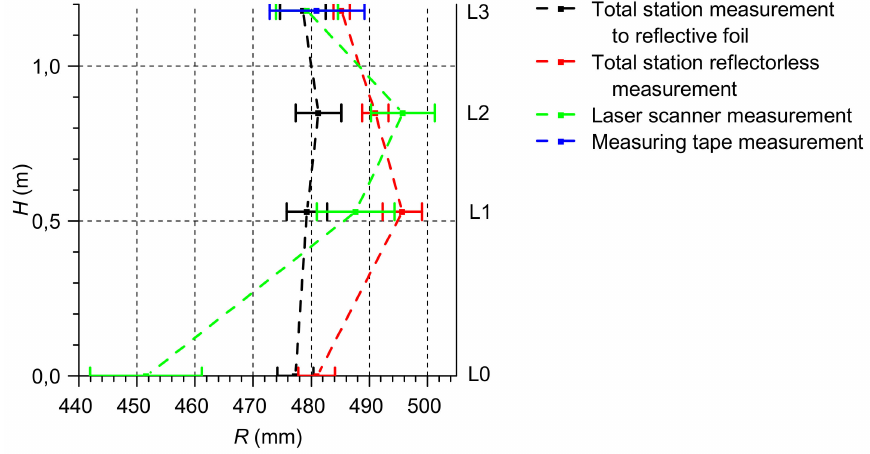
Figure 6. Radius R at the considered chimney’s measurement levels.